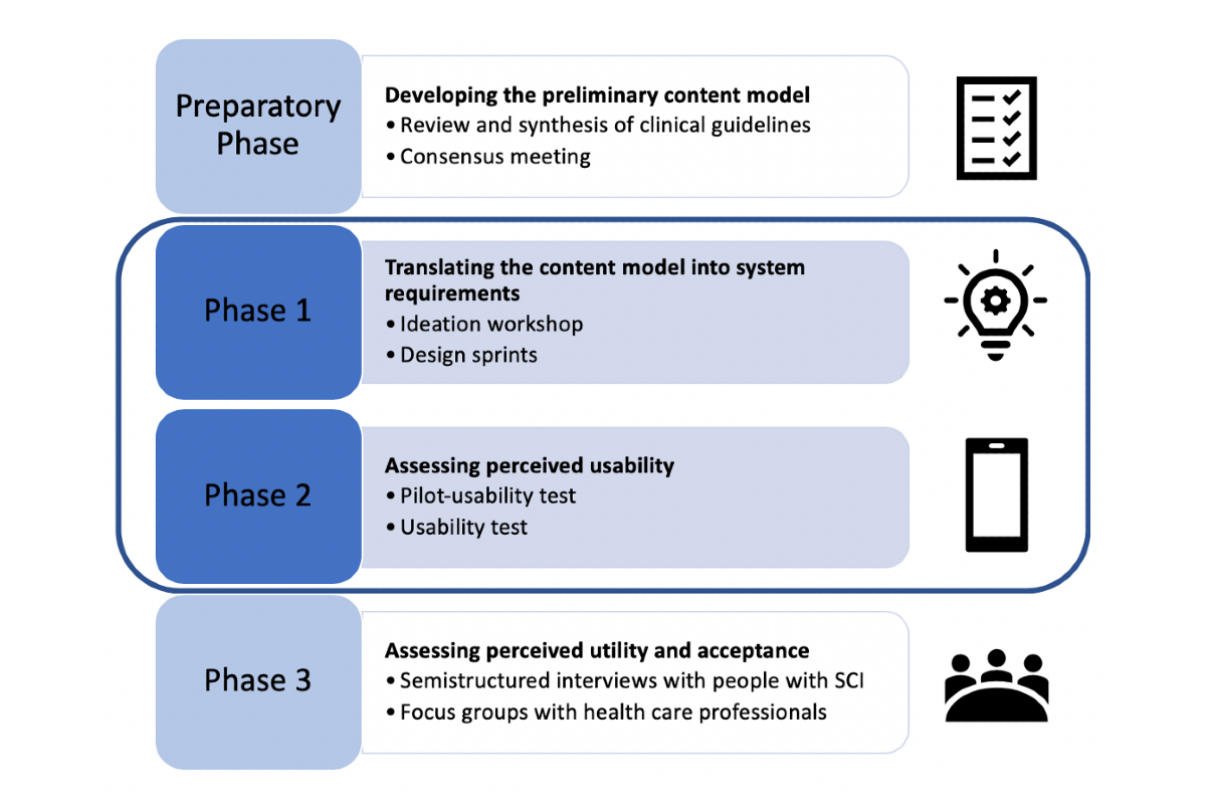
Figure 1. Co-design and development approach. SCI: spinal cord